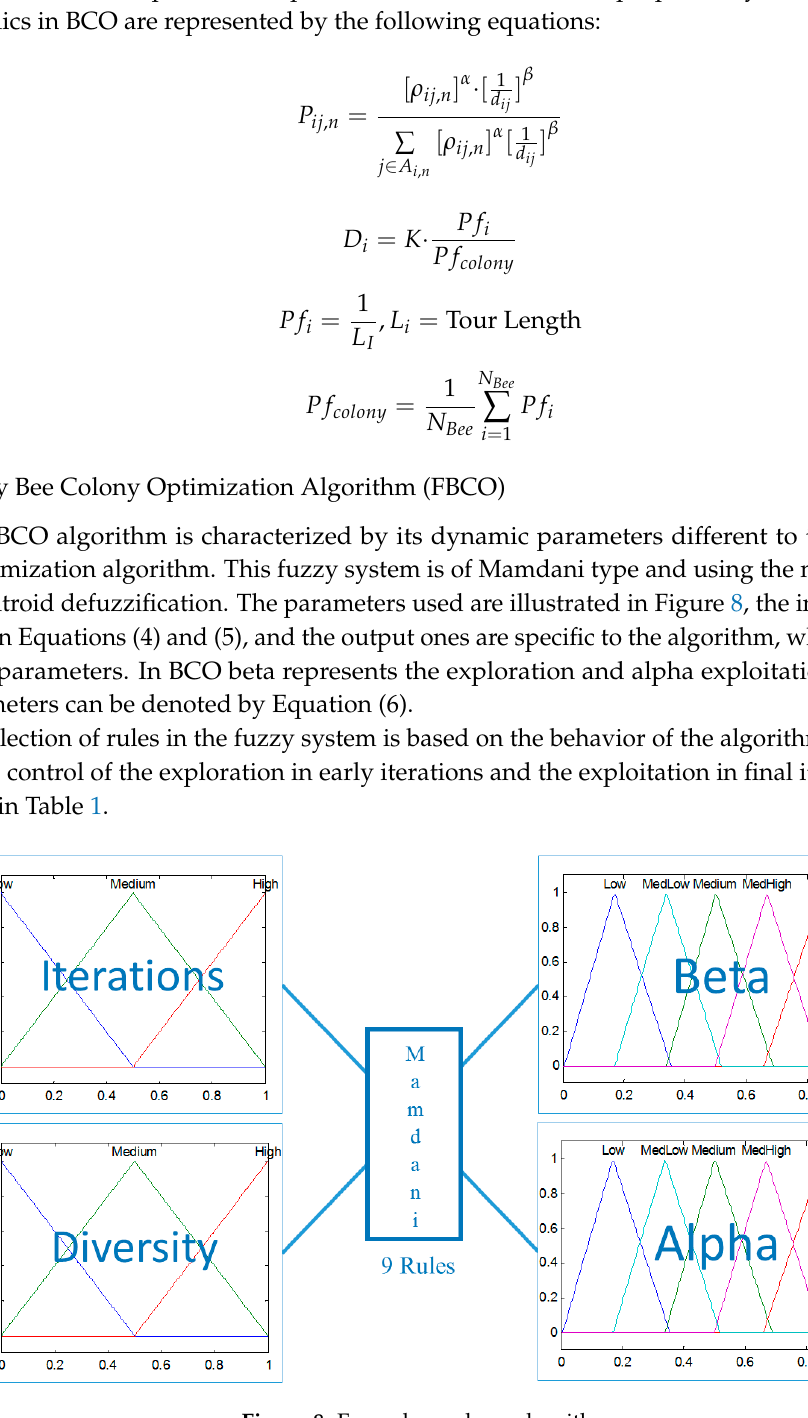
Figure 8. Fuzzy bee colony